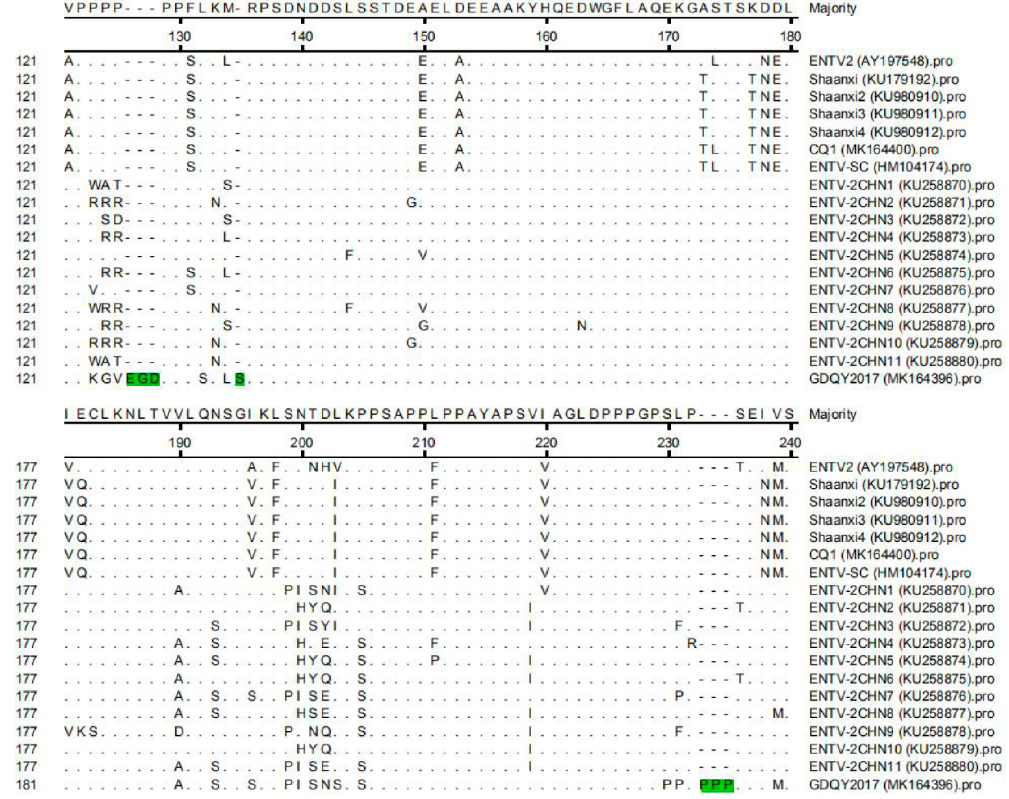
Figure 5. Multiple sequence alignment results of the gag protein of ENTV-2. The amino acid insertion sites (EGD-S-PPP) in the gag protein of GDQY2017 were marked with green color.